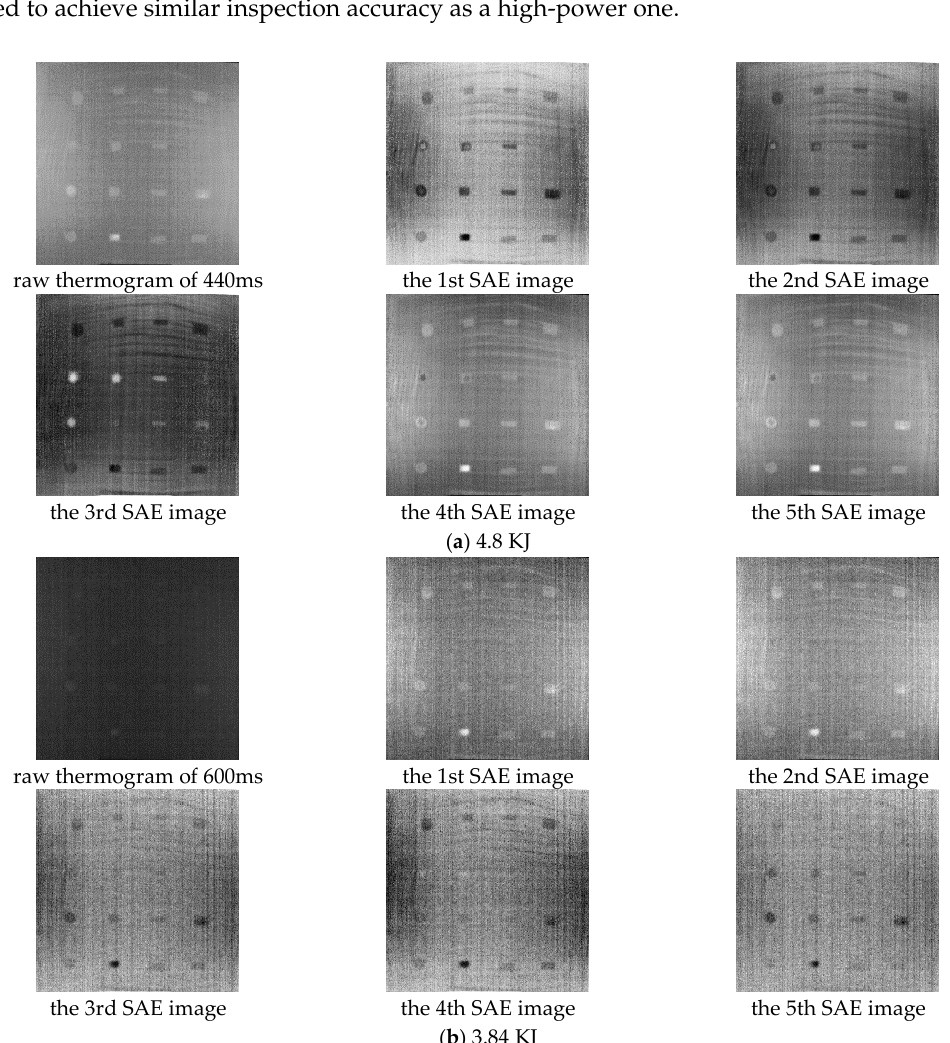
Figure 11. Raw thermogram and SAE images of specimen B. Flash heating energy: ( a ) 4.8 KJ, ( b ) 3.84 KJ.